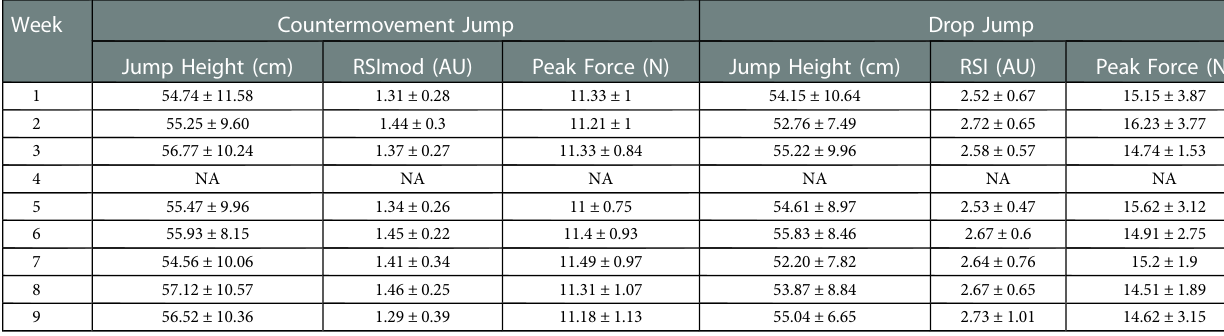
TABLE 1B descriptive statistics - weekly performance testing.